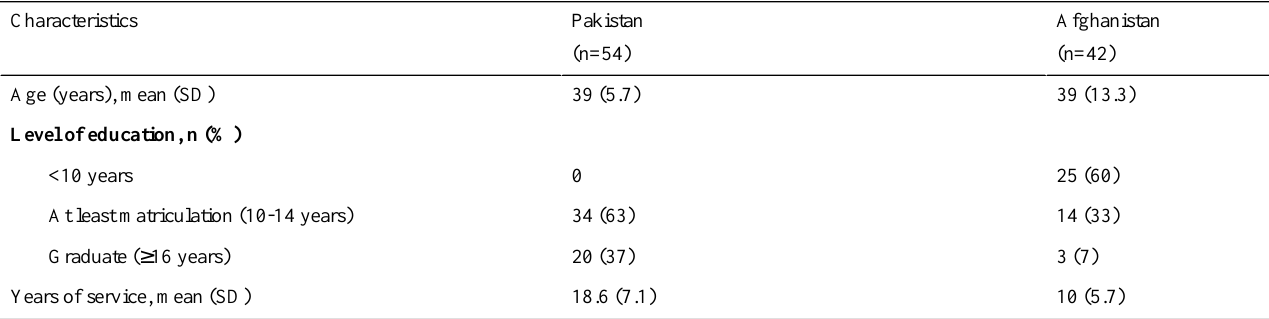
Table 2. Characteristics of the community health workers (CHWs) and lady health workers (LHWs).